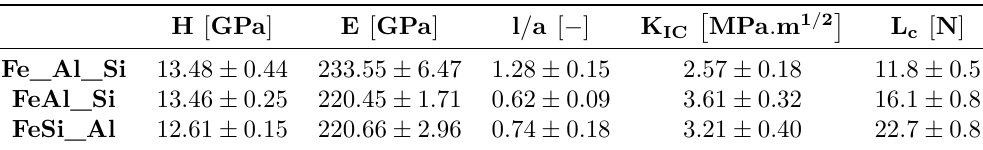
Table 1. Mechanical properties of FeAl20Si20 samples.